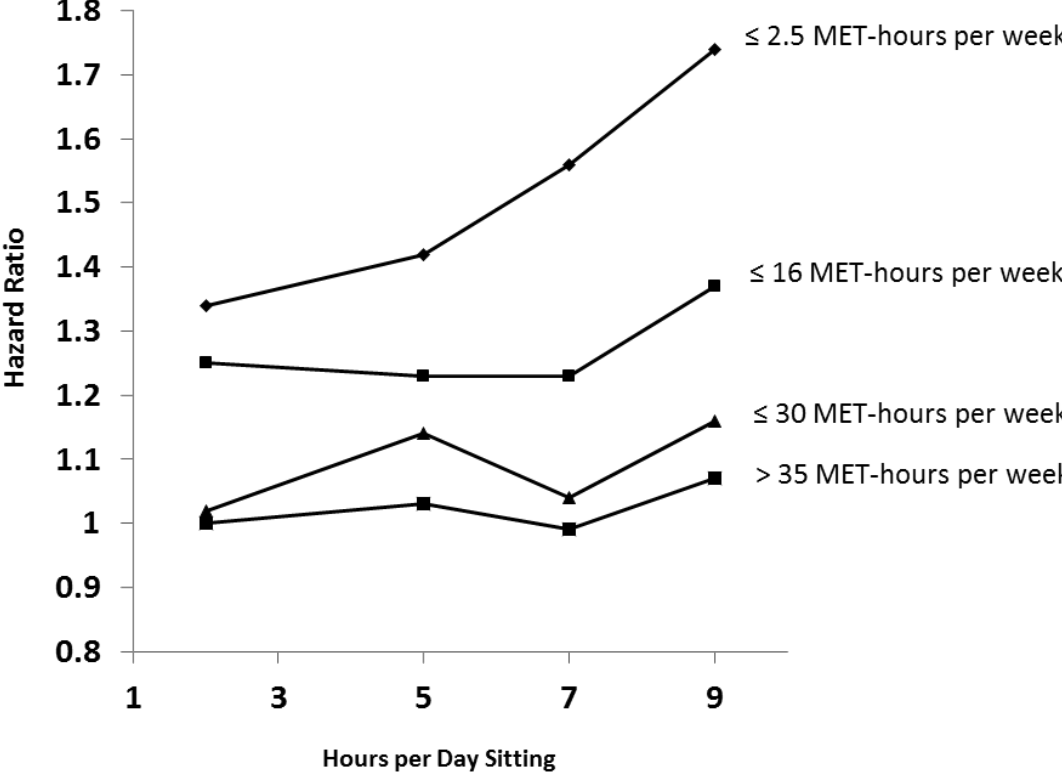
Figure F2-3. Relationship Between Sitting and Cardiovascular Disease Mortality, Stratified by Amount of Moderate-to-Vigorous Physical